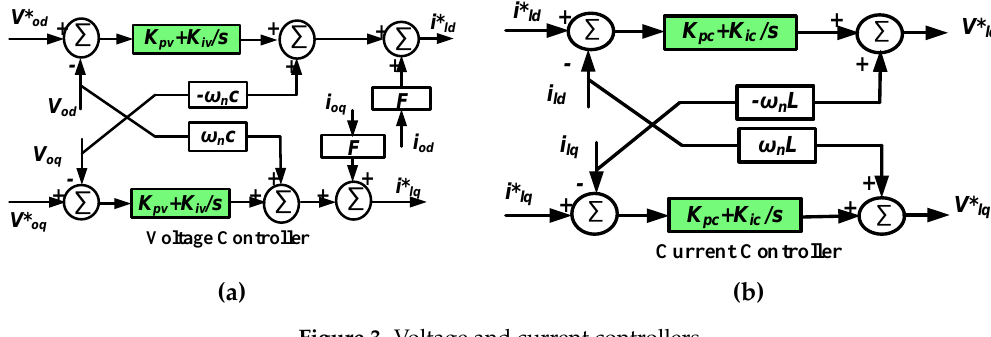
Figure 3. Voltage and current controllers.